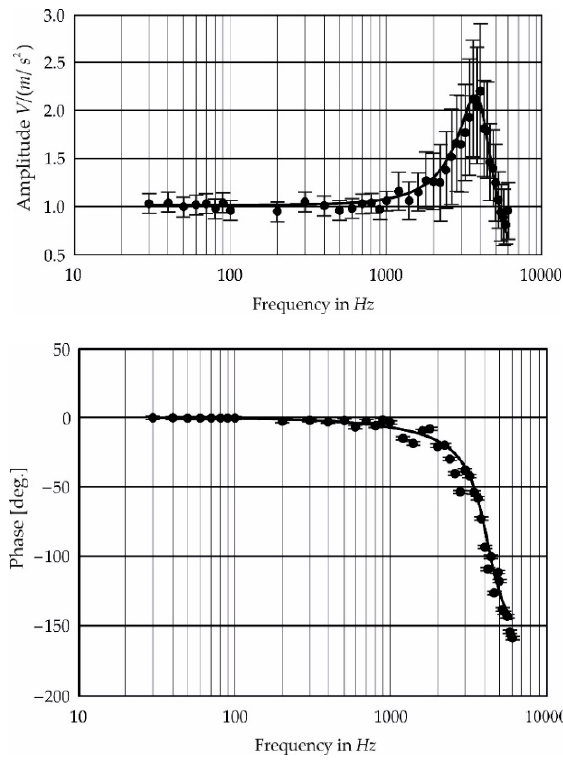
associated with these estimates are determined by using the MCP. The number M of MCts, which is equal to 2 × 10 5 , was taken as the minimum acceptable value obtained based on Equation (3). The coverage probability p equal to 0.95 was assumed in advance.